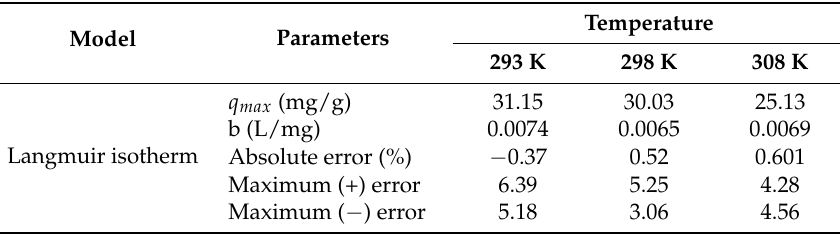
Table 3. Estimated parameters from Isotherm